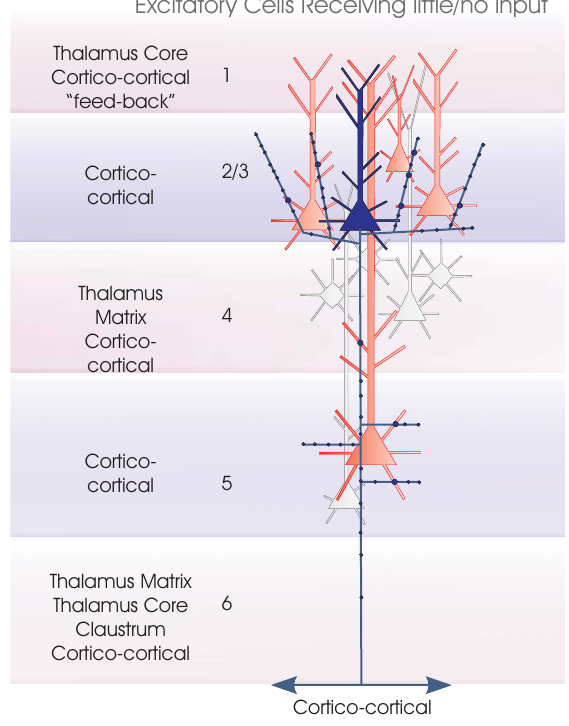
Figure 4. Layer 2/3 pyramidal cells . Layer 3 pyramidal cells are summarized in this cartoon (blue). The major inputs to each layer are indicated to the left. Spiny,excitatorypostsynaptictargetsthathavebeendemonstratedwithpaired intracellular recordings are shown in red and the white cells indicate those that have been tested but not to date shown to be significant targets for these axons. Where a class of spiny excitatory cell is not indicated in a particular layer, it has not been tested sufficiently often with layer 3 pyramidal cells in pairedrecordingstodeterminewhetherortowhatextenttheconnectionexists. To date the majority of paired recordings have involved layer 3 pyramids. The outputs of layer 2 pyramids remain to be studied in detail.